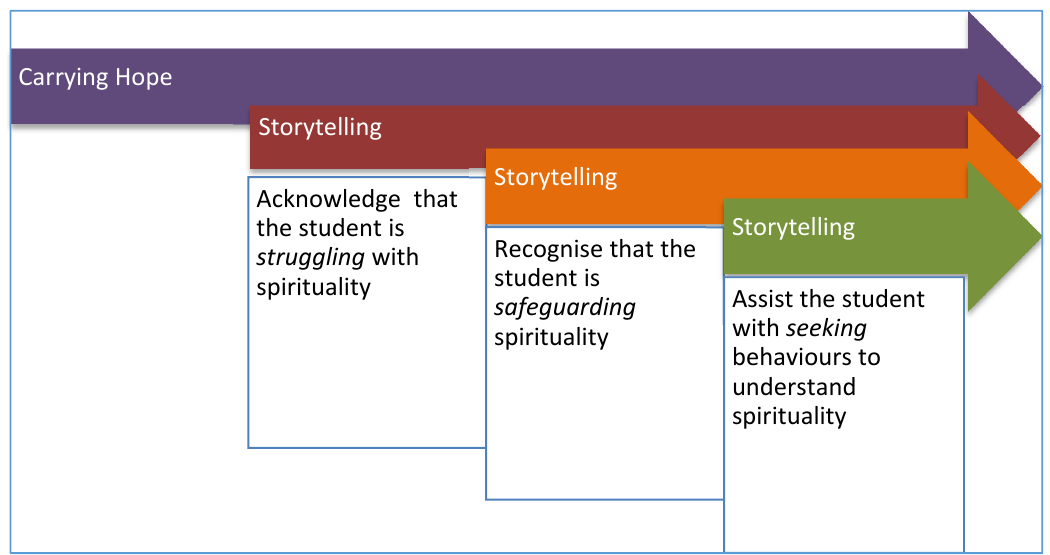
Figure 1. A model of pastoral care to support ‘carrying hope’.